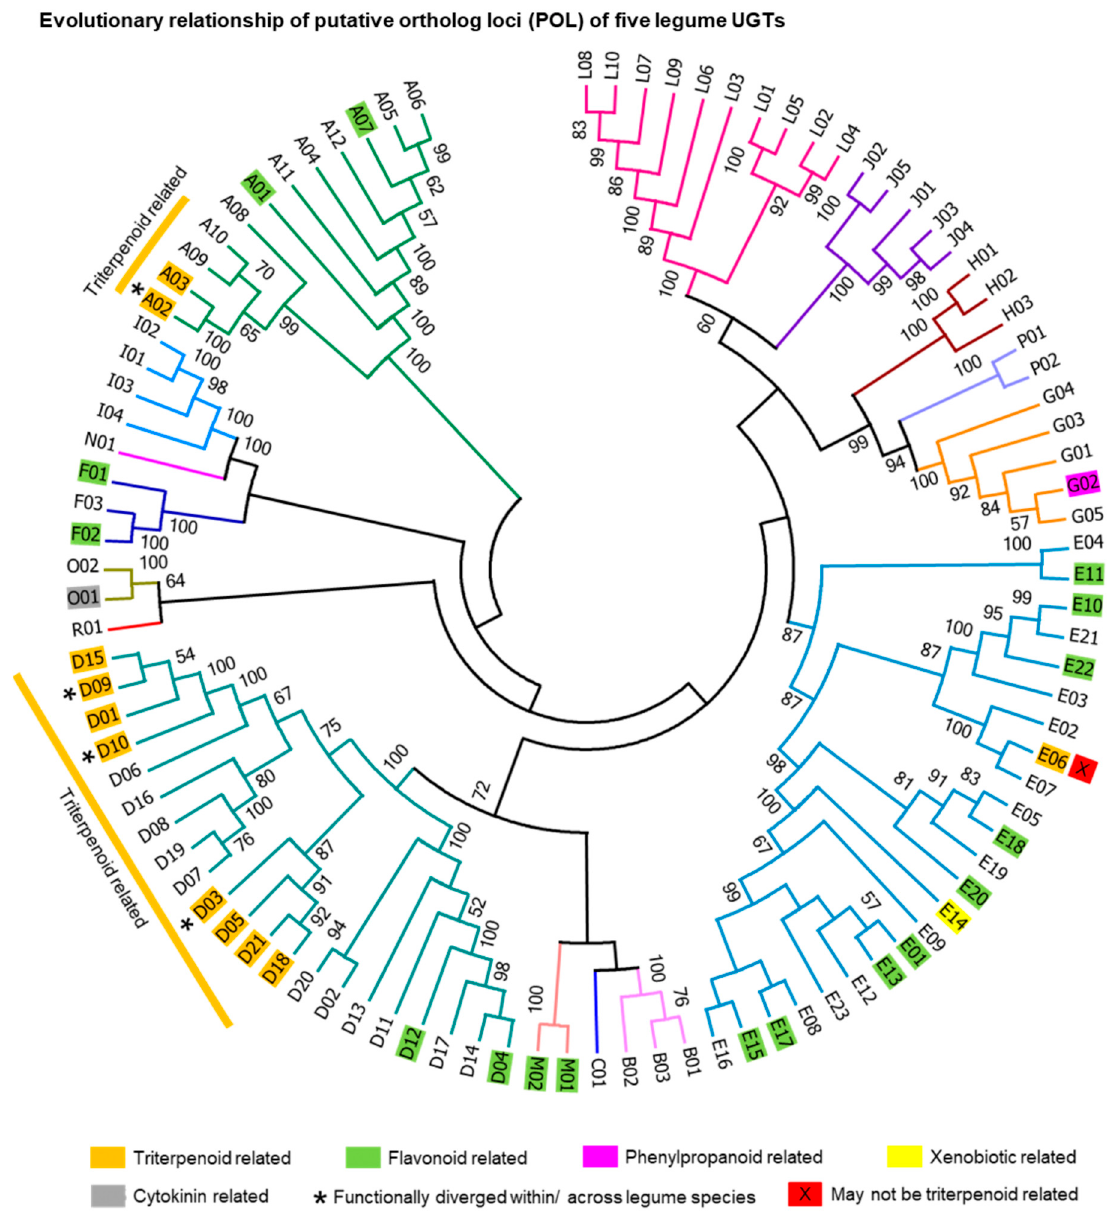
Figure 1. Evolutionary relationship of putative ortholog loci (POL) of five legume UGTs. A total of 196 full-length amino acid sequences covering all phylogenetic groups (A–R, excluding K and Q) and POLs ( n = 98) were selected from Glycine max (number of UGTs = 86), Medicago truncatula (76), Phaseolus vulgaris (9), Lotus japonicus (8), Cajanus cajan (3), Trifolium pratense (3), Vigna radiata (3), Cicer arietinum (2), Arachis duranensis (4), Lupinus angustifolius (1), and Trifolium subterraneum (1). Each POL included two sequences, each from di ff erent species (See Text S1). Subtrees (i.e., UGT pairs) were compressed with corresponding POL numbers to understand the POL relationship. POLs highlighted in orange, green, purple, yellow, and gray backgrounds denote that at least one UGT from that POL has been characterized for the glycosylation of triterpenoids, flavonoids, phenylpropanoids, xenobiotics, and cytokinin’s respectively. The first letter of each POL represents their phylogenetic